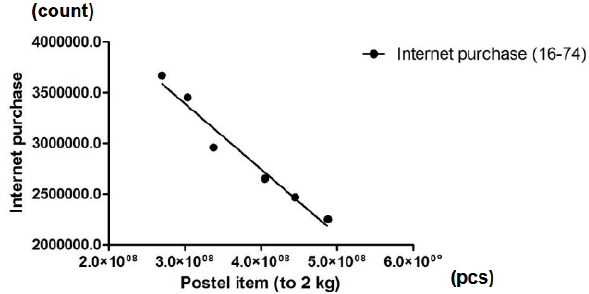
Figure 1: Dependence of postal item on individuals purchasing over the Internet.